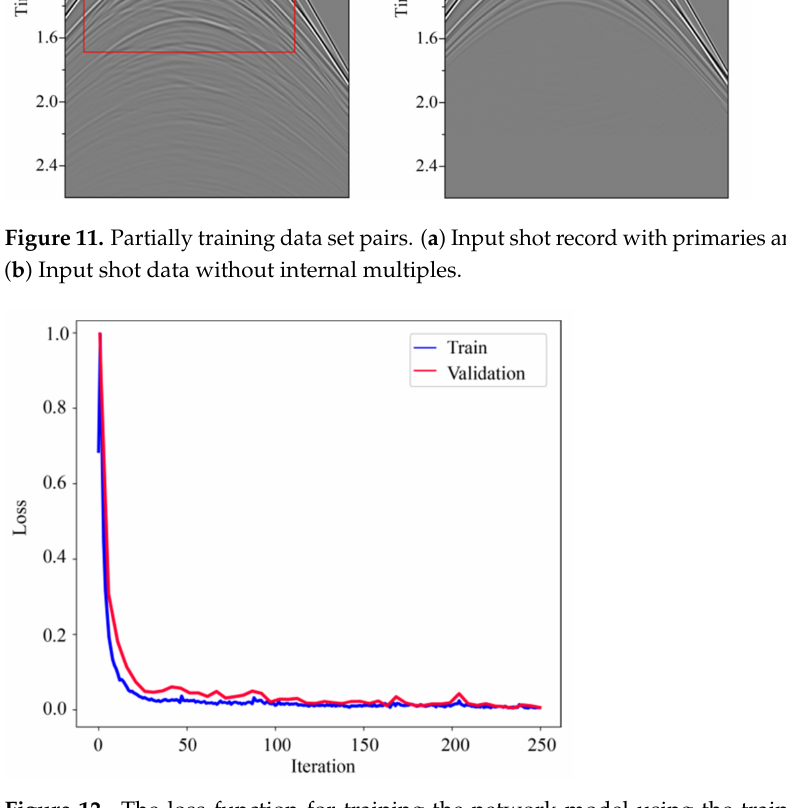
Figure 12. The loss function for training the network model using the training data sets in the Syncline model